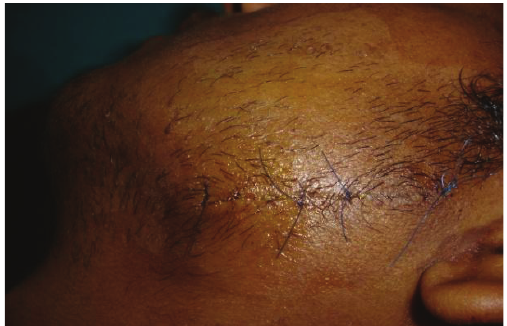
Figure 12: Sutures